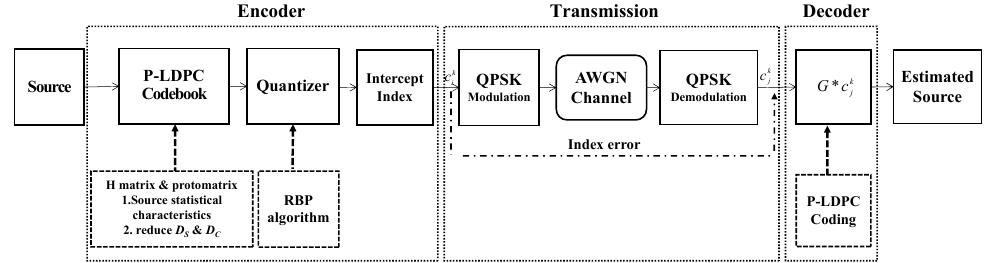
Figure 1. Lossy compression transmission system using P-LDPC codes over AWGN channels for Bernoulli